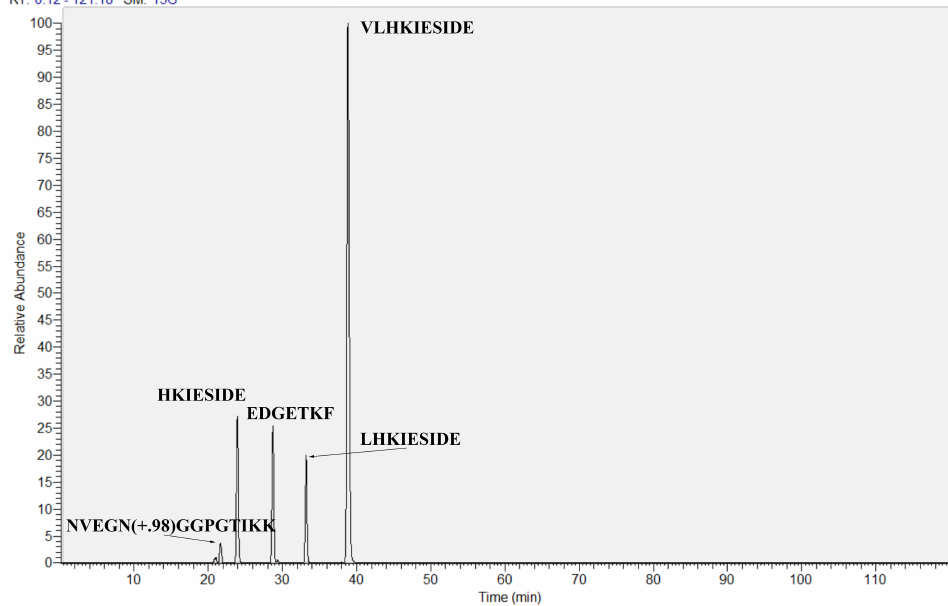
Figure 5. LC-MS/MS chromatogram of the 5 most abundant proteolytic fragments of Gly m 4 identified into basolateral chambers after crossing of the digest through Caco-2